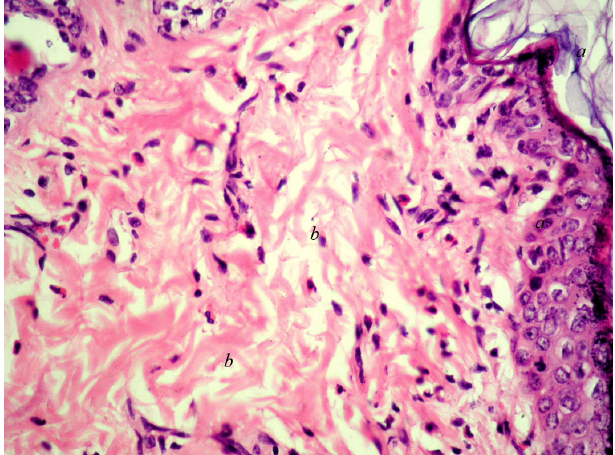
Fig. 2. Histological structure of guinea pig skin on the 14th day of treatment: a – epidermis; b – dermis (single erythrocytes in the thickness). Hematoxylin and eosin. EG. 10, vol. 20